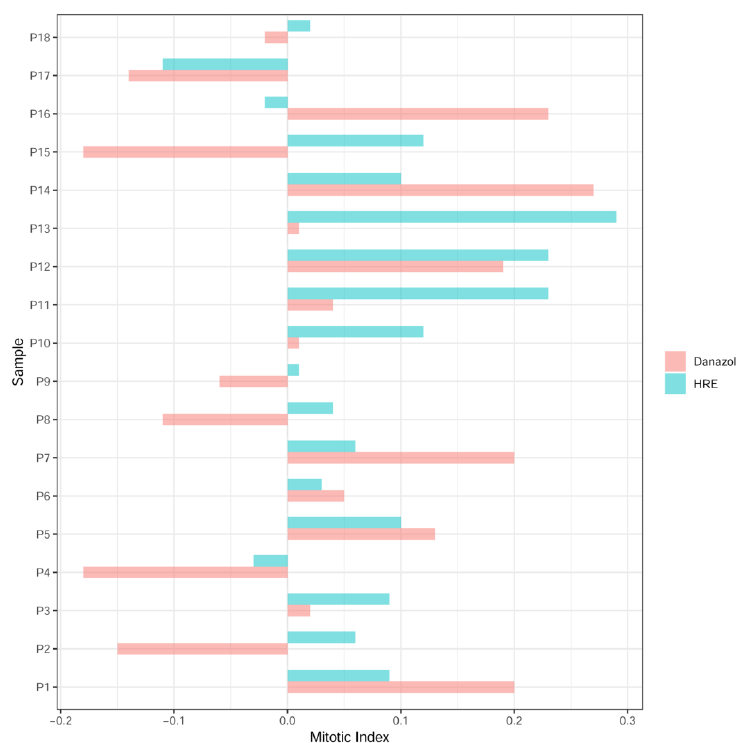
Figure 3. Toxicity of HRE and danazol treatment on circulating lymphocytes from healthy donors based on the relative change in the mitotic index after HRE and danazol treatment (1 µ g / mL) compared to control values. Two slides were used to establish the mitotic index for each condition.